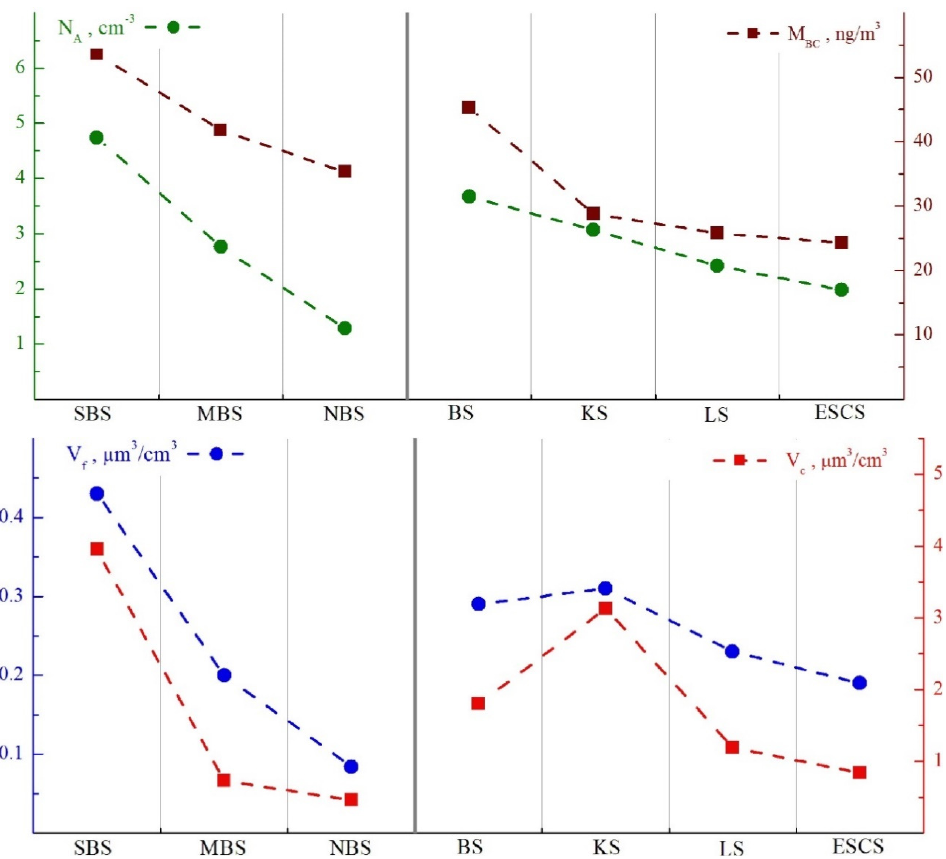
Figure 2. Multiyear (2007–2018) average concentrations of aerosol and black carbon in different regions of the Arctic Ocean: in three parts of the Barents Sea (SBS, MBS, NBS; left side), and over the Arctic seas (BS, KS, LS, ESCS; right side). Table 3. Average values and standard deviations (±SD) of aerosol characteristics over the Arctic seas using data from multiyear measurements in the 2007–2018 expeditions.